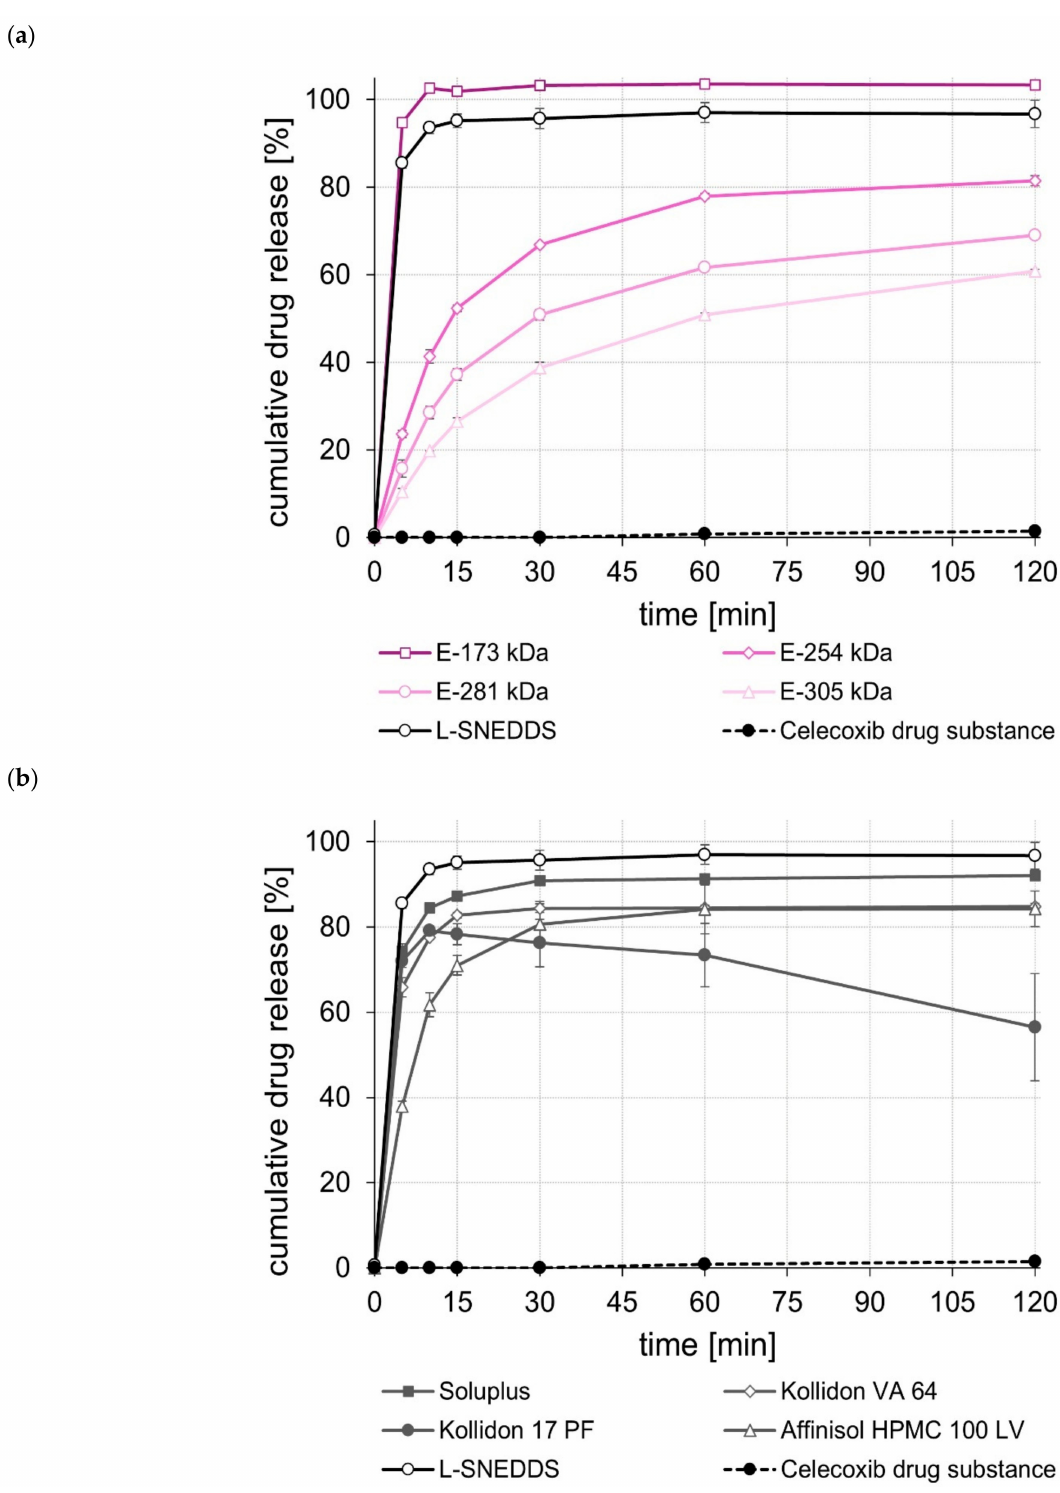
Figure 1. Dissolution profiles of the celecoxib drug substance and celecoxib L- and S-SNEDDS based on ModE ( a ), as well as the celecoxib drug substance and celecoxib L- and S-SNEDDS based on other marketed (co)polymers ( b ) in 500 mL 0.1 M HCl in USP apparatus II. Each value designates the mean ± S.D. ( n =